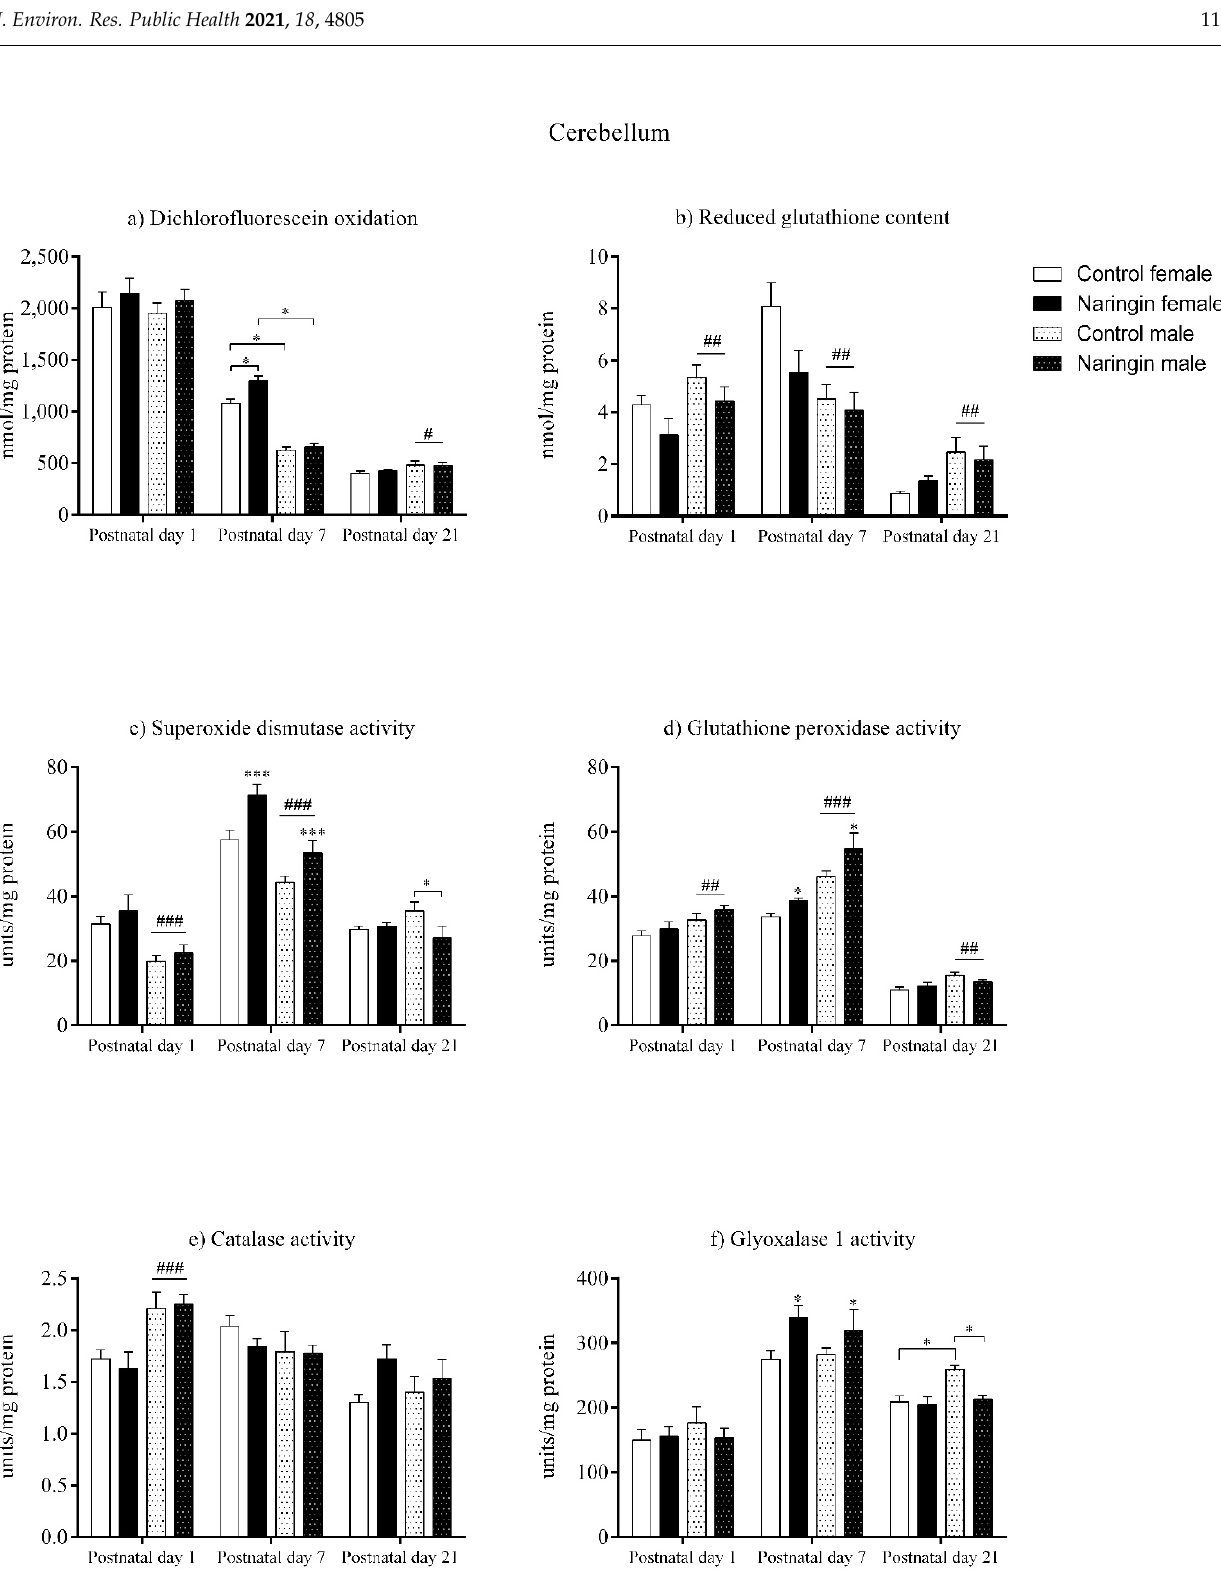
Figure 4. Effects of maternal naringin supplementation during the third week of gestation on the ( a ) dichlorofluorescein oxidation, ( b ) reduced glutathione content, ( c ) superoxide dismutase activity, ( d ) glutathione-peroxidase activity, ( e ) catalase activity, and ( f ) glyoxalase 1 activity in the offspring’s cerebellum on postnatal days 1, 7, and 21. Results are expressed as mean ± S.E.M. Control female n = 8, naringin female n = 8, control male n = 8, naringin male n = 6. * p < 0.05; *** p < 0.001 # p < 0.05; ## p < 0.01; ### p < 0.001 (two-way ANOVA). Asterisks represent a main supplementation effect, and the hashes on bars represent a main sex effect. The asterisks on bars (single bracket) represent the significant comparisons by Sidak’s post-hoc test when interactions occurred.